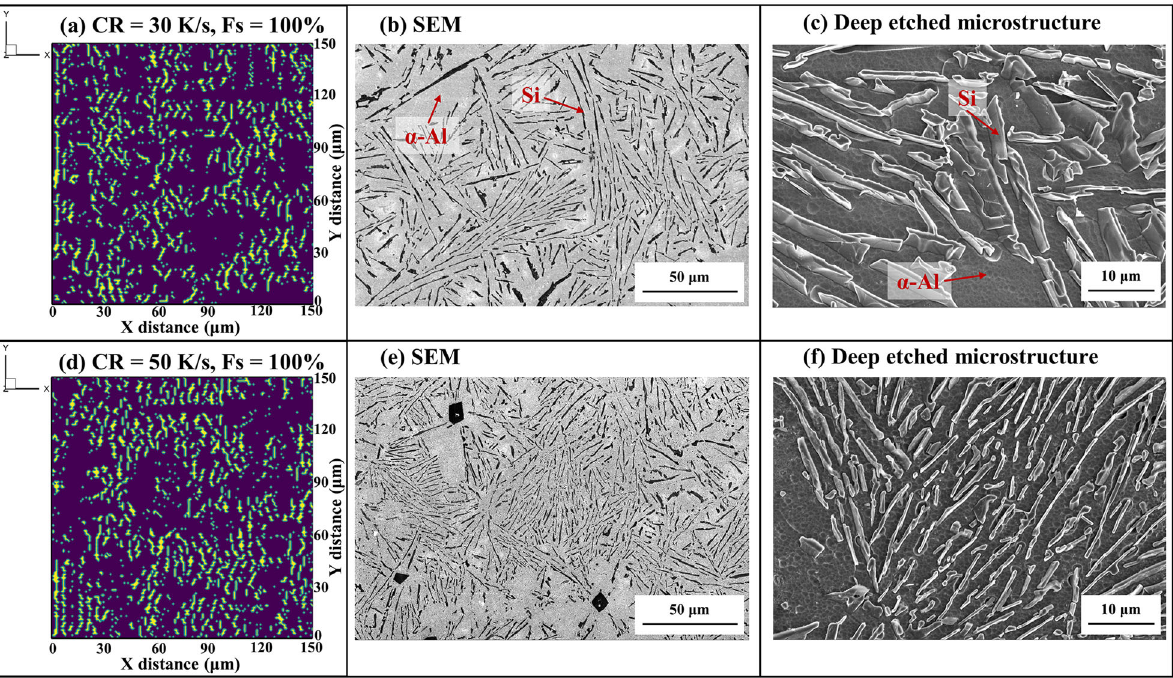
Fig. 5 Comparison between simulations and experiments. Comparison between simulated microstructure and experimental microstructure: a – c Cooling rate of 30 K s − 1 , and d – f cooling rate of 50 K s − 1 . ( α -Al is in blue color and Si is in yellow